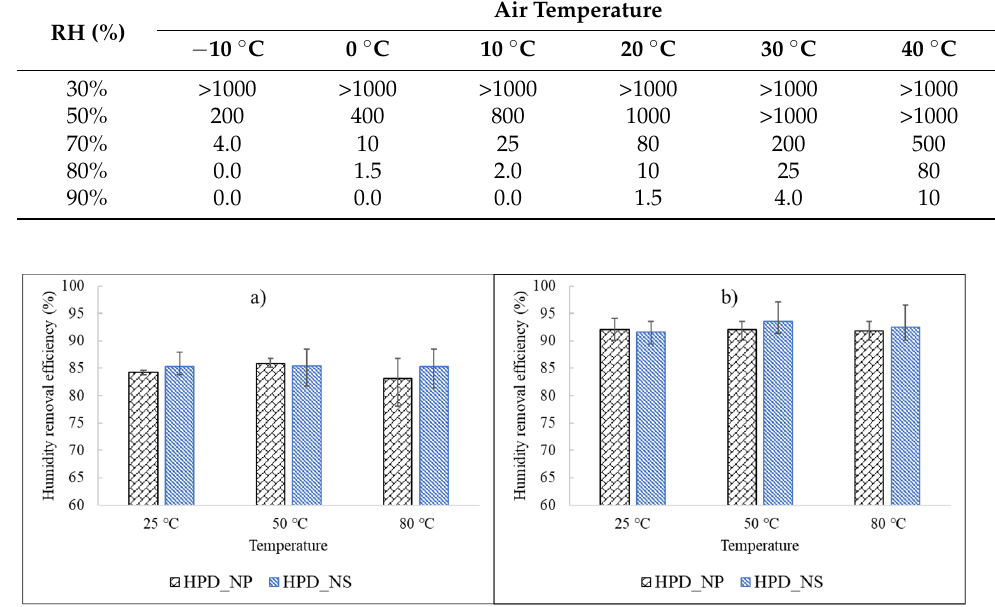
Figure 5. Humidity removal efficiencies of HPD_NP and HPD_NS with respect to various operating temperatures and inlet humidity: ( a ) low humidity (4%); ( b ) high humidity (17%).